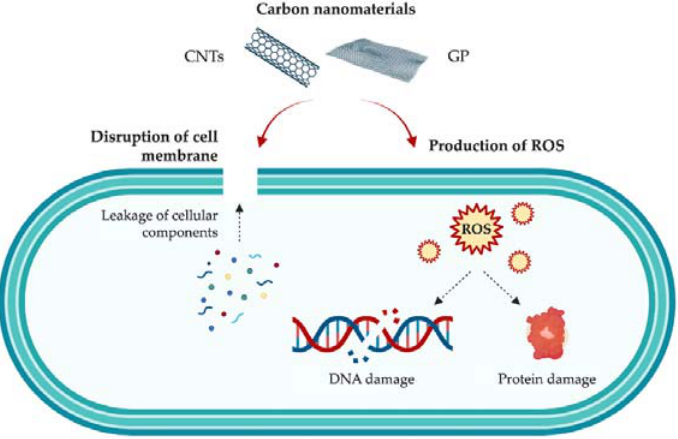
Figure 2. Schematic representation of the mechanisms of action of carbon nanomaterials, namely GP and CNTs, against bacteria.